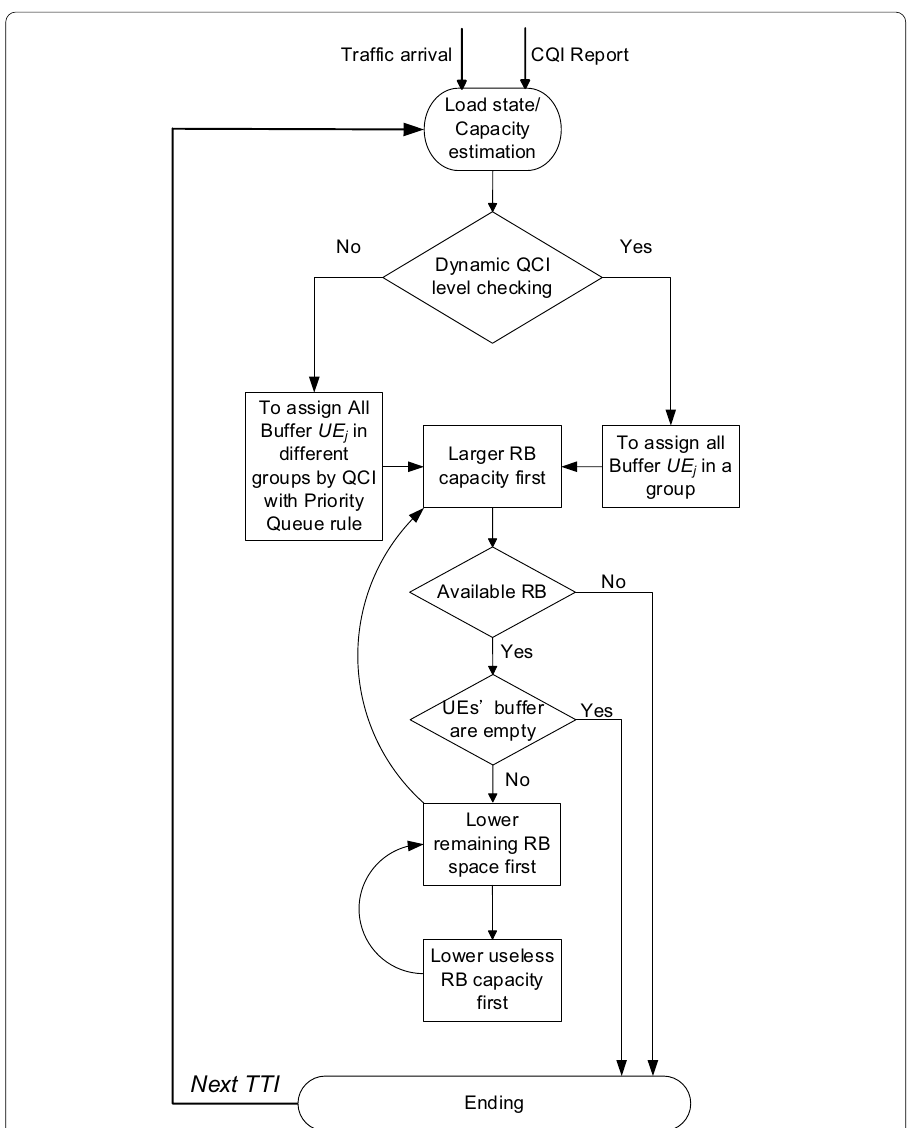
Fig. 4 Overview of EURA scheme algorithm; Diagram of our proposed EURA scheme includes these one checking policy and three novel